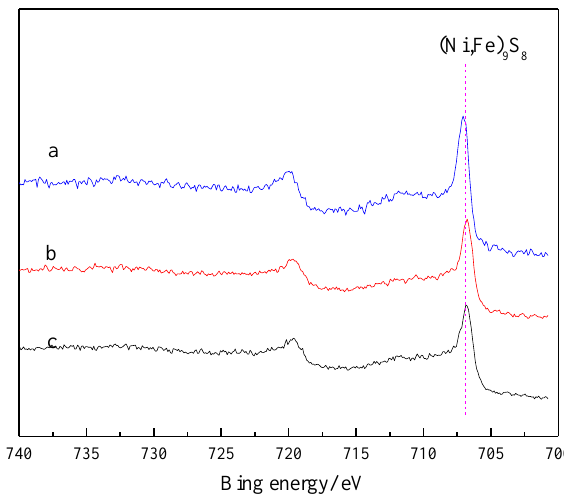
Figure 7. Fe 2p XPS spectra of leached samples with different conditions: ( a ) initial Fe 3+ = 0 g/L, leached for 14 days; ( b ) initial Fe 3+ = 3 g/L, leached for 14 days; ( c ) initial Fe 3+ = 9 g/L, leached for 52 days .